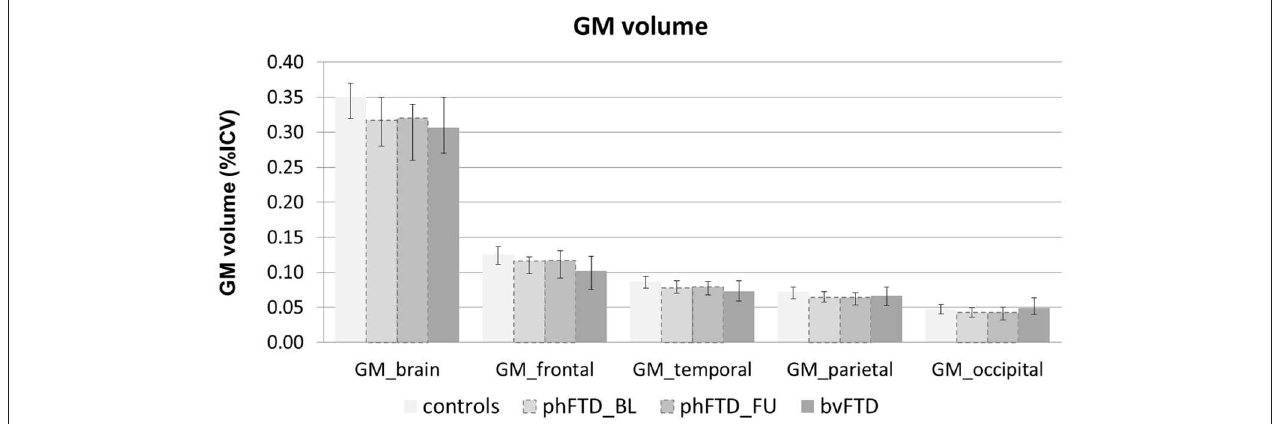
FIGURE 2 | Whole-brain and regional gray matter (GM) volume expressed as percentage of intracranial volume (ICV) shown for each group (controls, baseline phFTD, follow-up phFTD, bvFTD). The range of scores is indicated by a minimum-maximum bar. bvFTD, behavioral variant frontotemporal dementia; phFTD, phenocopy frontotemporal dementia; BL, baseline; FU, follow-up.